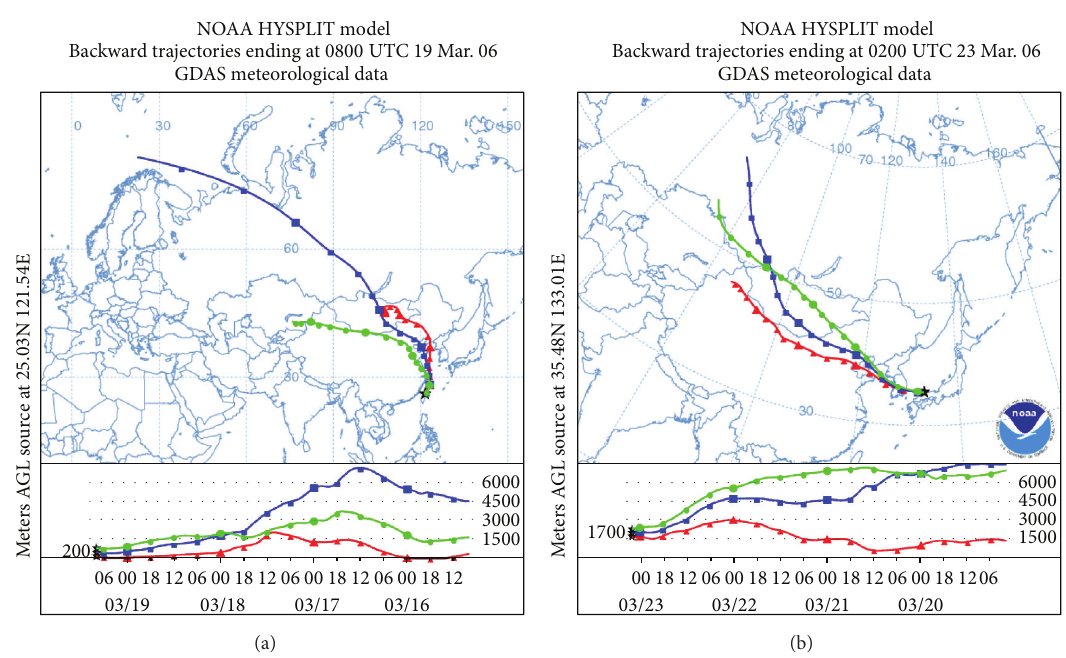
Figure 5: NOAA HYSPLIT backward trajectories of (a) southeastward and (b) eastward dust events and their vertical profiles initiated from Taipei, Taiwan, and Matsue, Japan, respectively. Initial heights are 200, 500, and 800 m for the southeastward event and 1700, 2000, and 2300 m for the eastward event. Trajectories are marked every 6